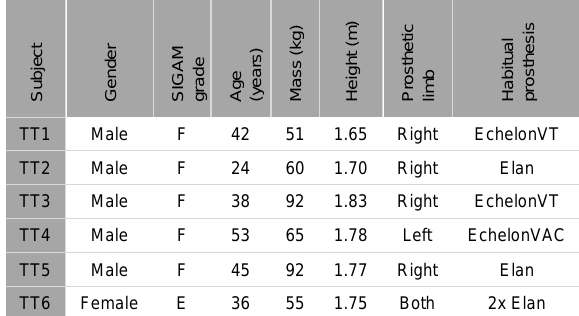
Table 1: Characteristics of the participants. Please note EchelonVT is a hydraulic ankle with an in-built vertical shock pylon/ torsion adaptor and EchelonVAC is a hydraulic ankle with an in-built mechanism for generating elevated vacuum suspension.